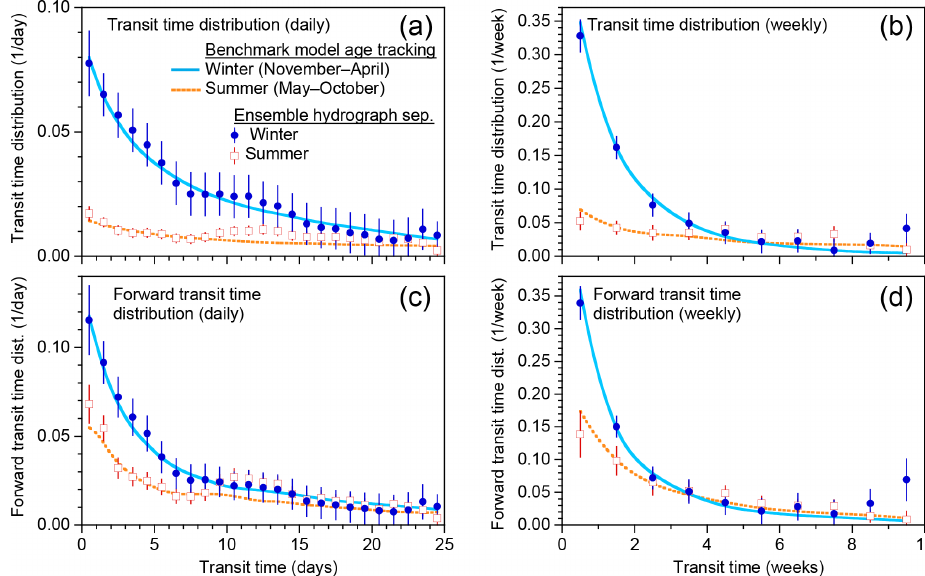
Figure 16. Backward and forward transit time distributions ( a, b and c, d , respectively) compared for summer (May–October) and winter (November–April) months, from the benchmark model with Mediterranean (Smith River) precipitation climatology and flashy catchment parameters. Solid circles and open squares show estimates from ensemble hydrograph separation (Eqs. 55 and 63); solid and dashed curves show the true TTDs determined by age tracking in the benchmark model. Panels (a, c) and (b, d) show TTDs estimated from daily and weekly sampling, respectively. Owing to larger and more frequent rainfalls during winter (see Fig. 1), transit time distributions calculated for the winter months show a much larger contribution of recent rainfall to current streamflow (a, b) and a much larger fraction of current precipitation becoming streamflow in the near future (c, d) . Ensemble hydrograph separation quantitatively captures the seasonal differences in the benchmark model’s transit time